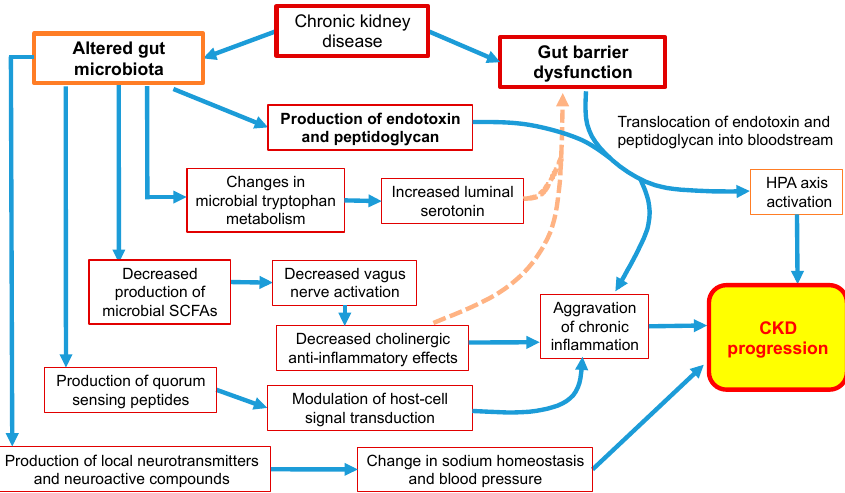
Figure 2. The effect of gut dysbiosis on neuroendocrine pathways in chronic kidney disease. The